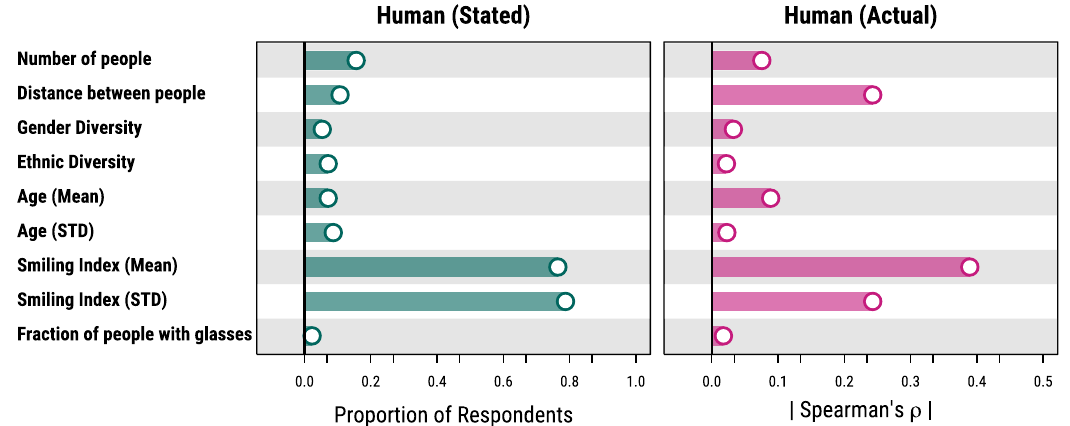
Figure 6. Analysis of the group characteristics used by the participants in Study 1 to make their predictions. The left panel shows the “stated” relevance, i.e., how often each group characteristic has been reported as important by the participants. The right panel shows the “actual” relevance, i.e., absolute value of the correlation (Spearman correlation) between the predictions made by participants (escaped or not) and each of the nine